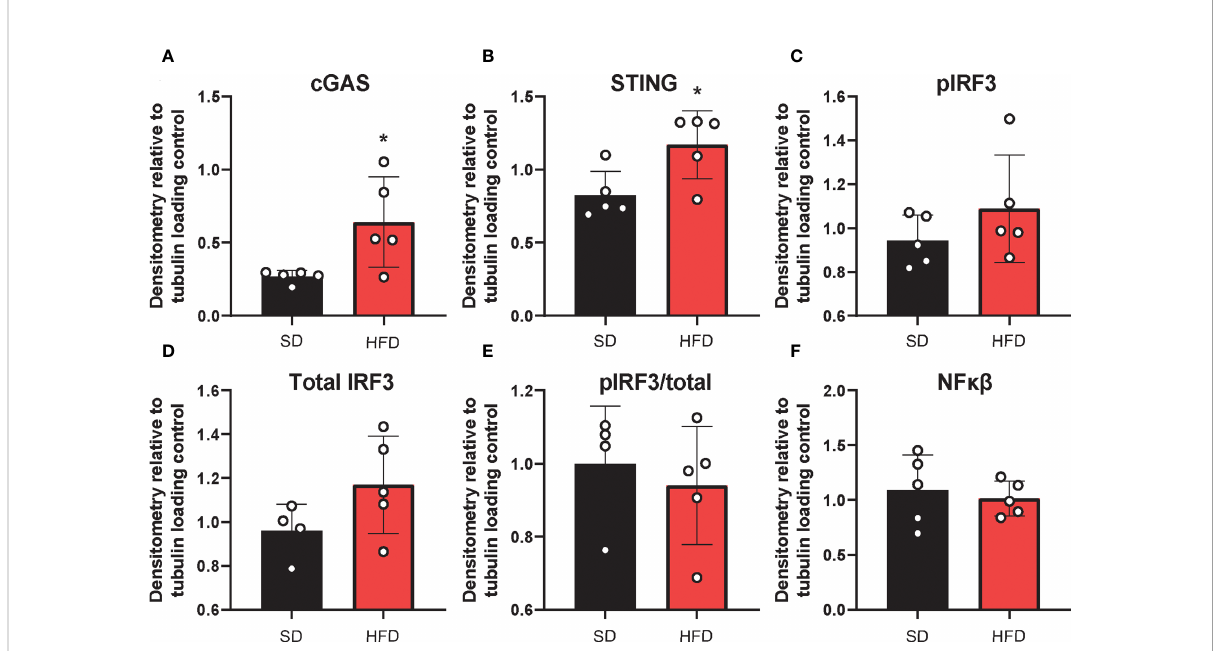
FIGURE 4 Hippocampal cGAS/STING protein expression. Expression in male BL/6 mice fed standard diet (SD) or high fat diet (HFD). Data represented as cGAS (A) , STING (B) , pIRF3 (C) , total IRF3 (D) , pIRF3/total (E) , and NF kb (F) relative protein expression. Protein expression quanti fi ed as average band intensity relative to tubulin loading control; * p